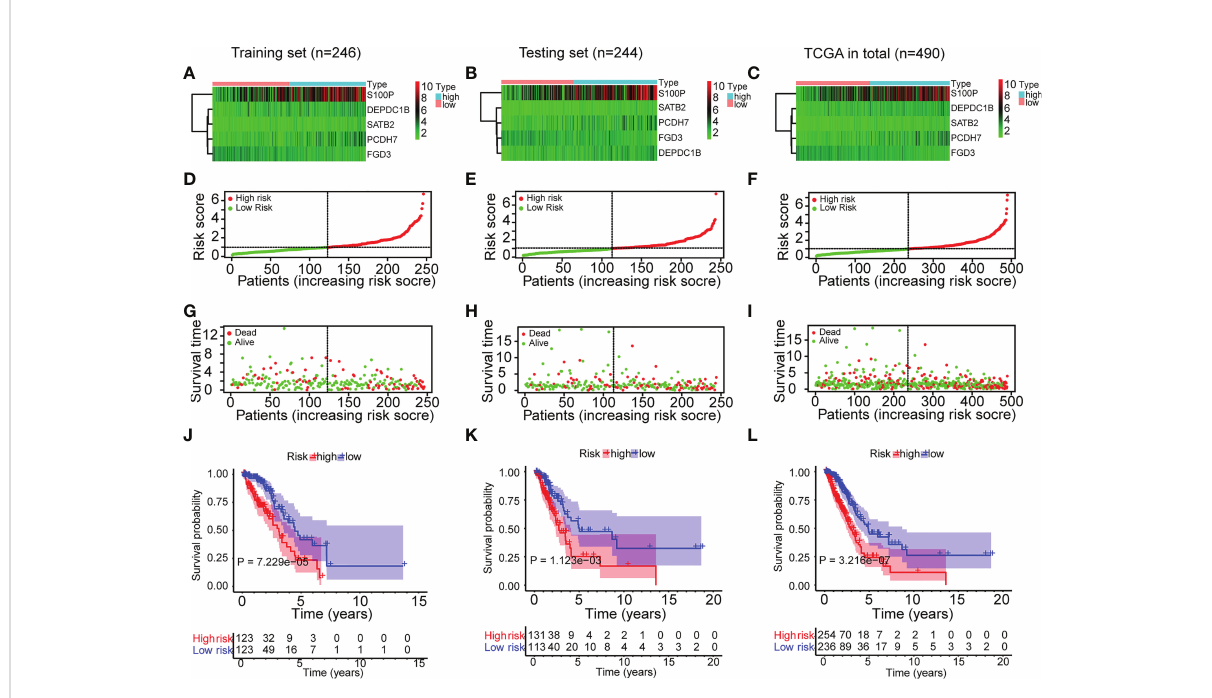
FIGURE 3 Characteristics and survival analyses of the ERS in the three sets of TCGA-LUAD cohort. (A – C) The gene expression heatmap of the ERS in the three sets of TCGA-LUAD cohort. (D – F) The risk score distribution plot indicated that the ERS effectively categorized TCGA-LUAD patients into high-risk and low-risk groups. (G – I) The survival time distribution plot indicated that the high-risk group had more fatalities and shorter survival times. (J – L) The Kaplan-Meier survival study demonstrated the disparity in survival status and survival time between the two risk